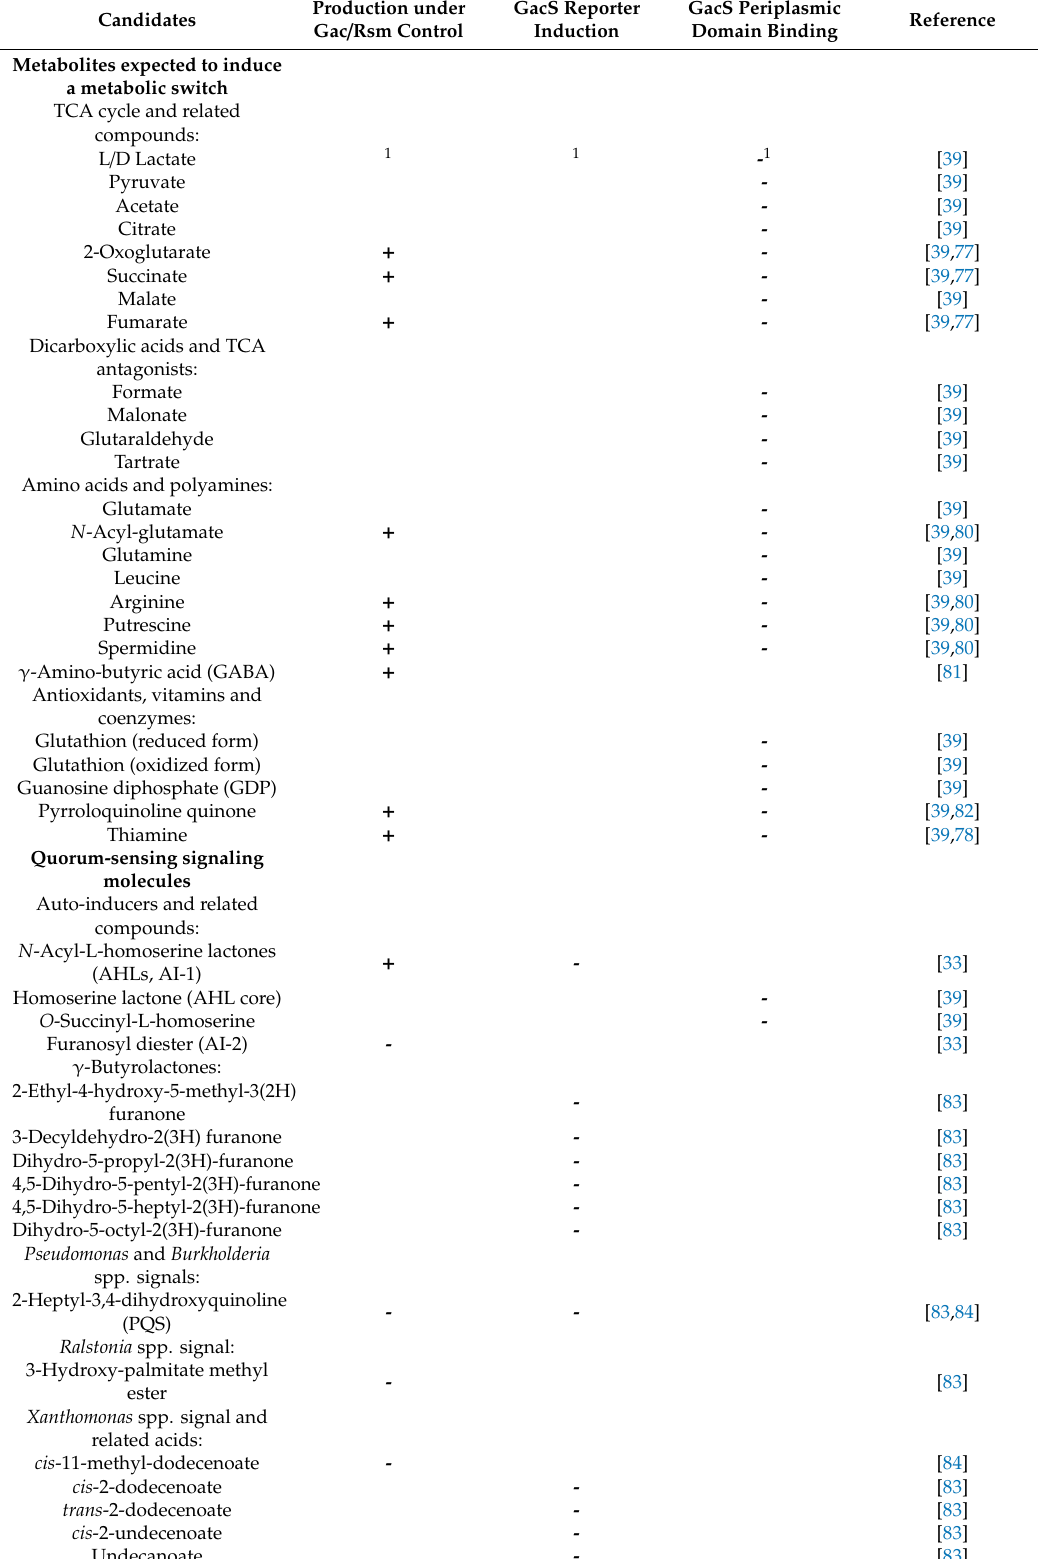
Table 1. GacS signal candidates previously studied in